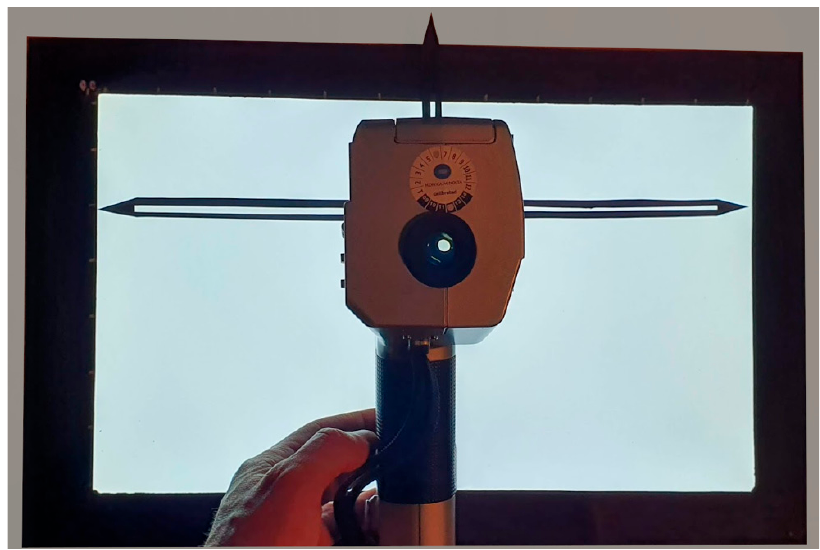
Figure 2. Example of characterisation of the LED panel (the same approach was used to characterise the cube).